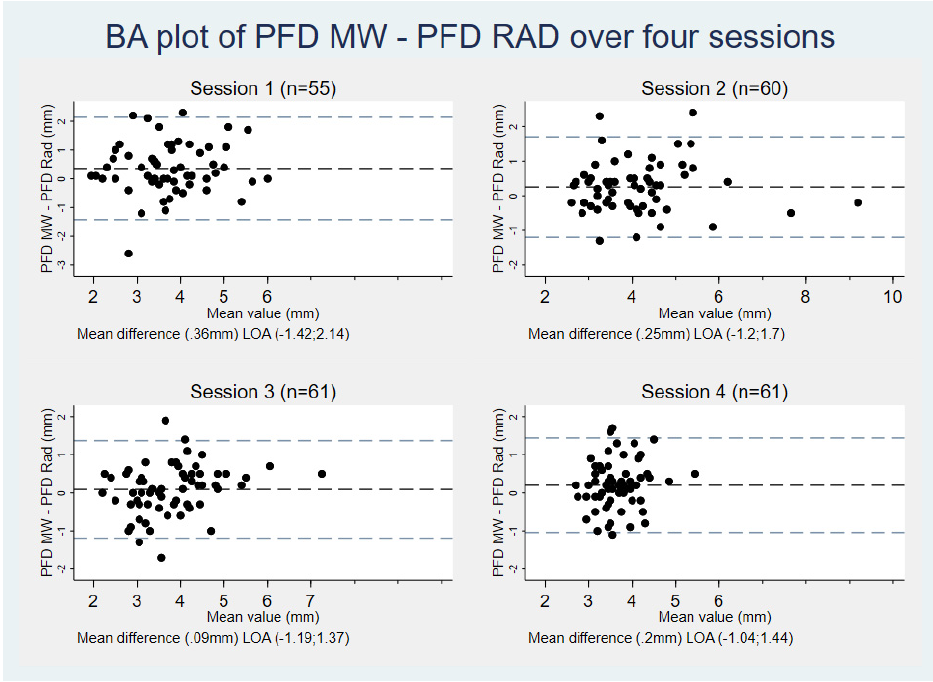
Figure 2. Bland–Altman plot of differences in PFD measurements between radiologists and midwives across four sessions of supervised pediatric hip scans. PFD = Pubo-femoral distance, MW = Midwife, RAD = Radiologist, LOA = Limits of agreement.